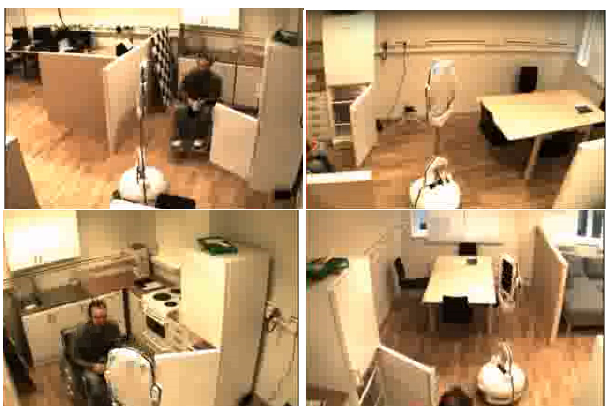
Figure 3. A screen shot from different angles of one of the pilot users doing the look-away formation observed in [21].